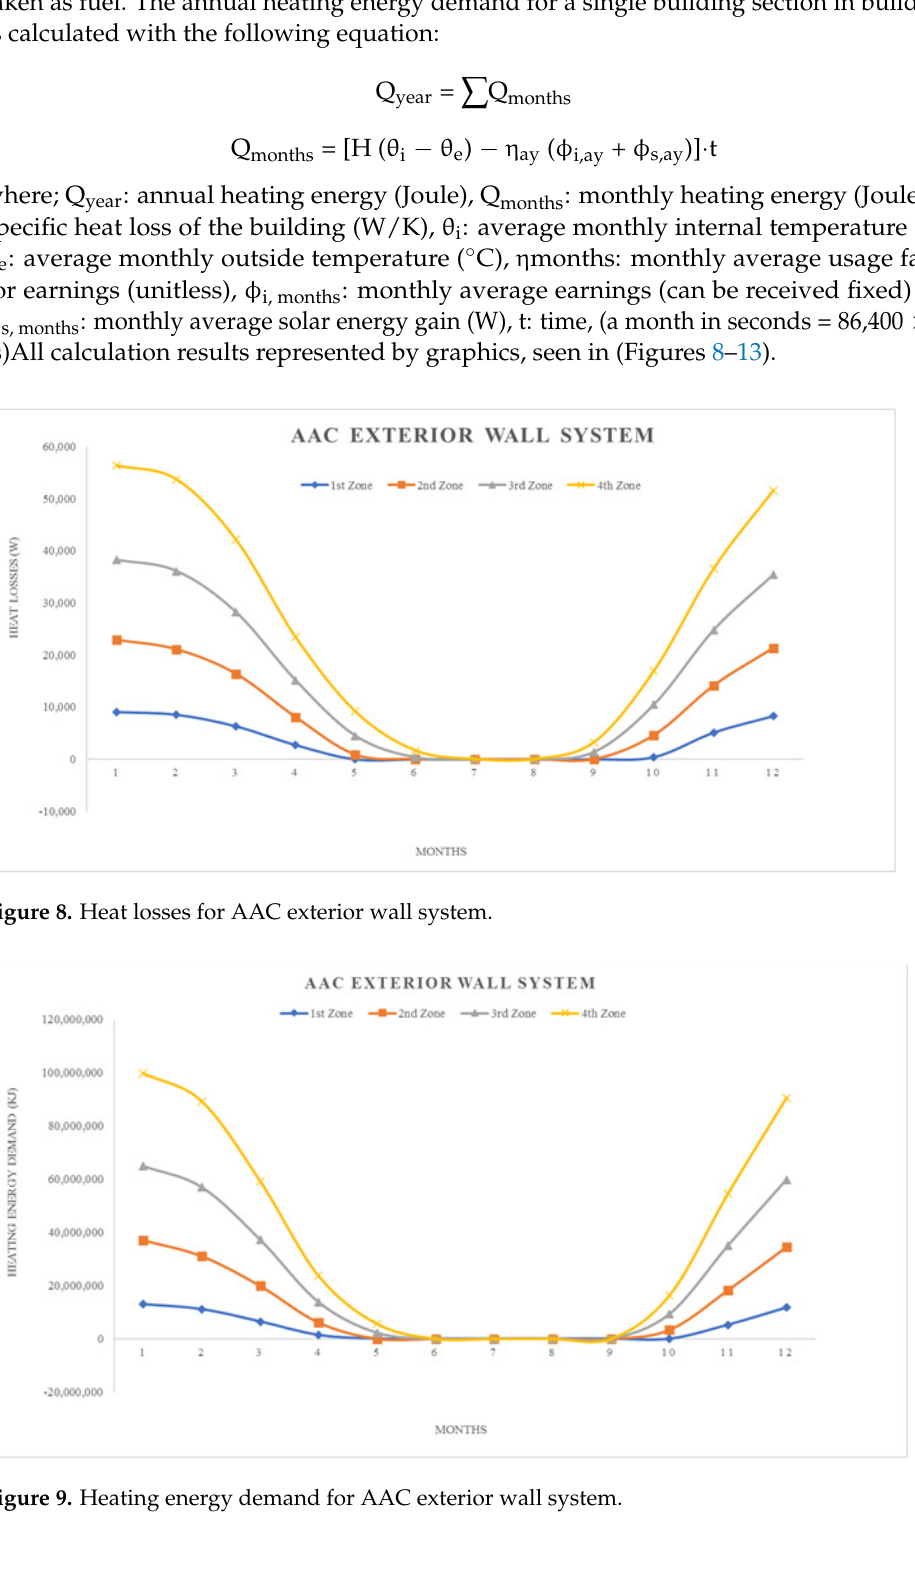
Figure 10. Heat losses for brick exterior wall system . Figure 11. Heating energy demand for brick exterior wall system .